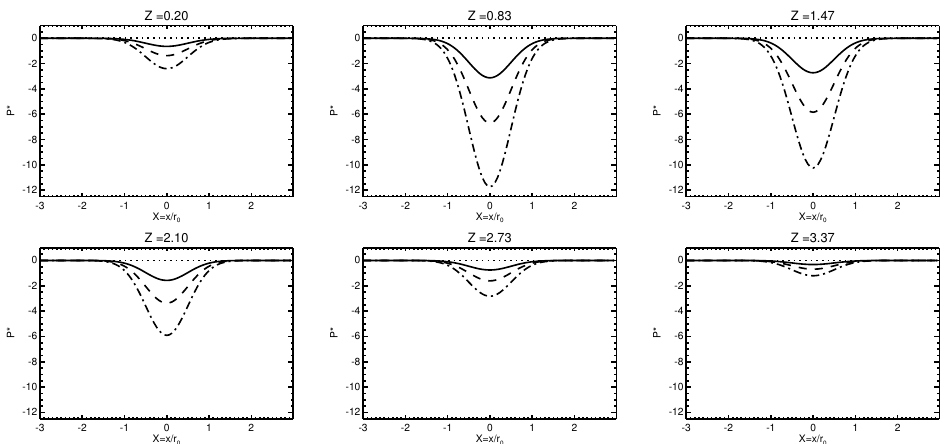
(cid:16) (cid:17) P ∗ = p − p at across the vortex at different ρ v 2 0